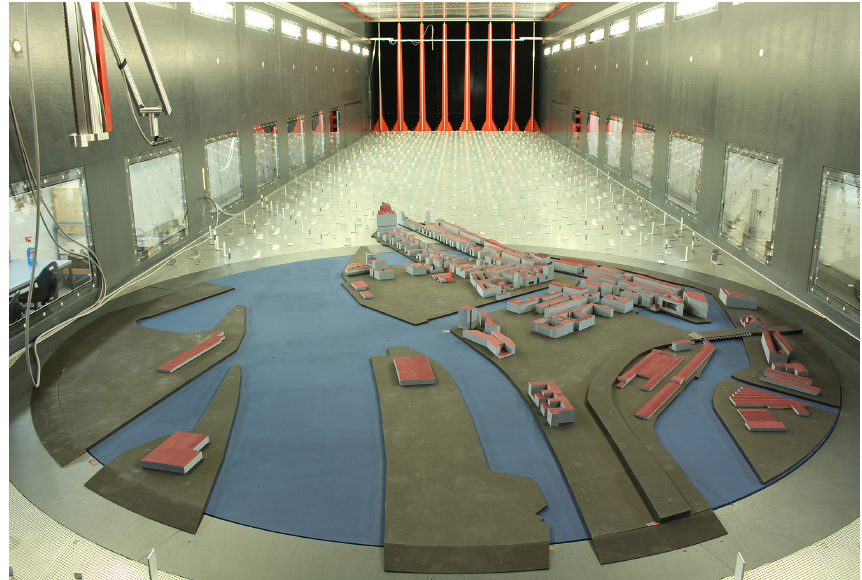
Figure 1. Photograph of the building setup within the wind-tunnel facility “WOTAN” for an approaching flow of 290 ◦ . Please note that contrary to the depicted orientation, an approaching flow from 110 ◦ was used in this study.